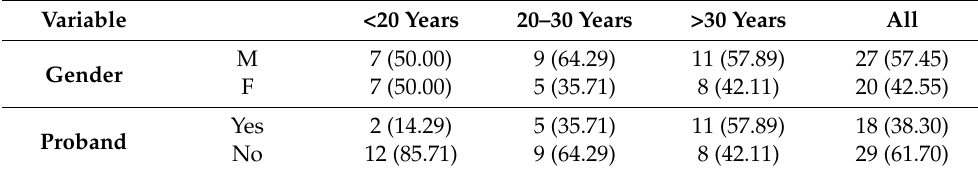
Table 1. Baseline demographical and genetic